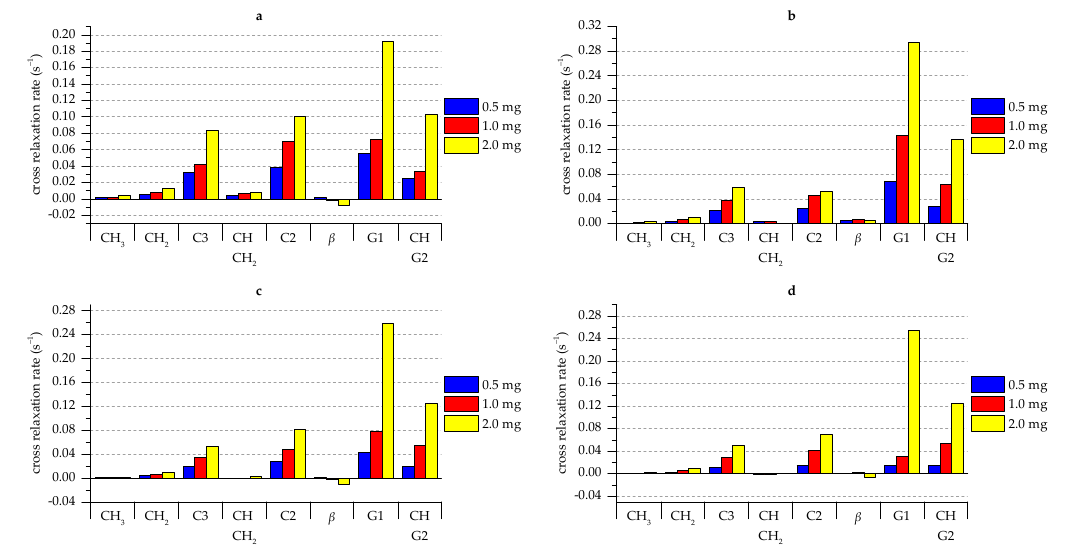
Figure A3. Cross relaxation rates of the aromatic protons (cross peak 1 ( a ), cross peak 2 ( b ), cross peak 3 ( c ), and cross peak 4 ( d )) of three different weighed amounts of tellimagrandin II 4 against different lipid protons with a mixing time of 0.1 s. The lipid proton assignations refer to Figure 5 and cross peak labels are defined in Chapter 3.3.